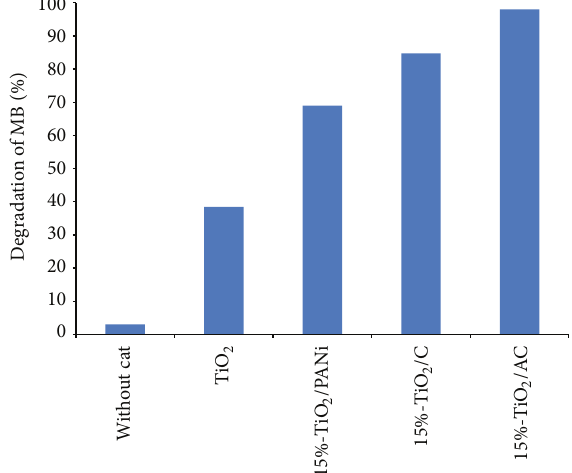
Figure 9: Photocatalytic degradation of methylene blue for bare TiO 2 , TiO 2 /PANi, TiO 2 /C, and TiO 2 /AC (0.05 mM MB and 90 min irradiation time).